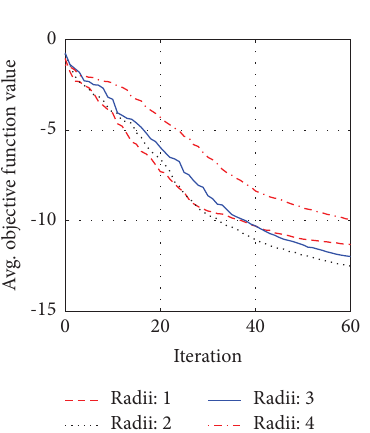
Figure 18: Average objective function value against algorithm iterations with variation in cluster radius. Te radius values are wavelength-normalized.